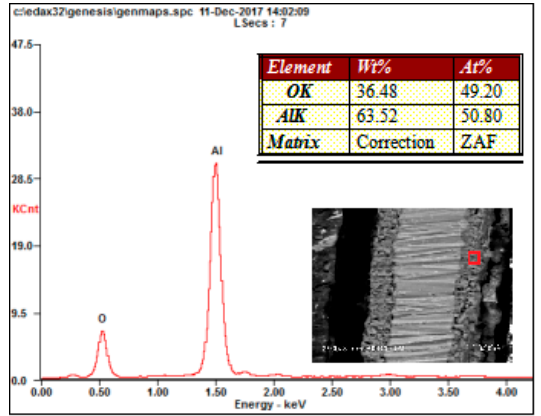
Figure 5. EDS analysis of the ceramic coatings.